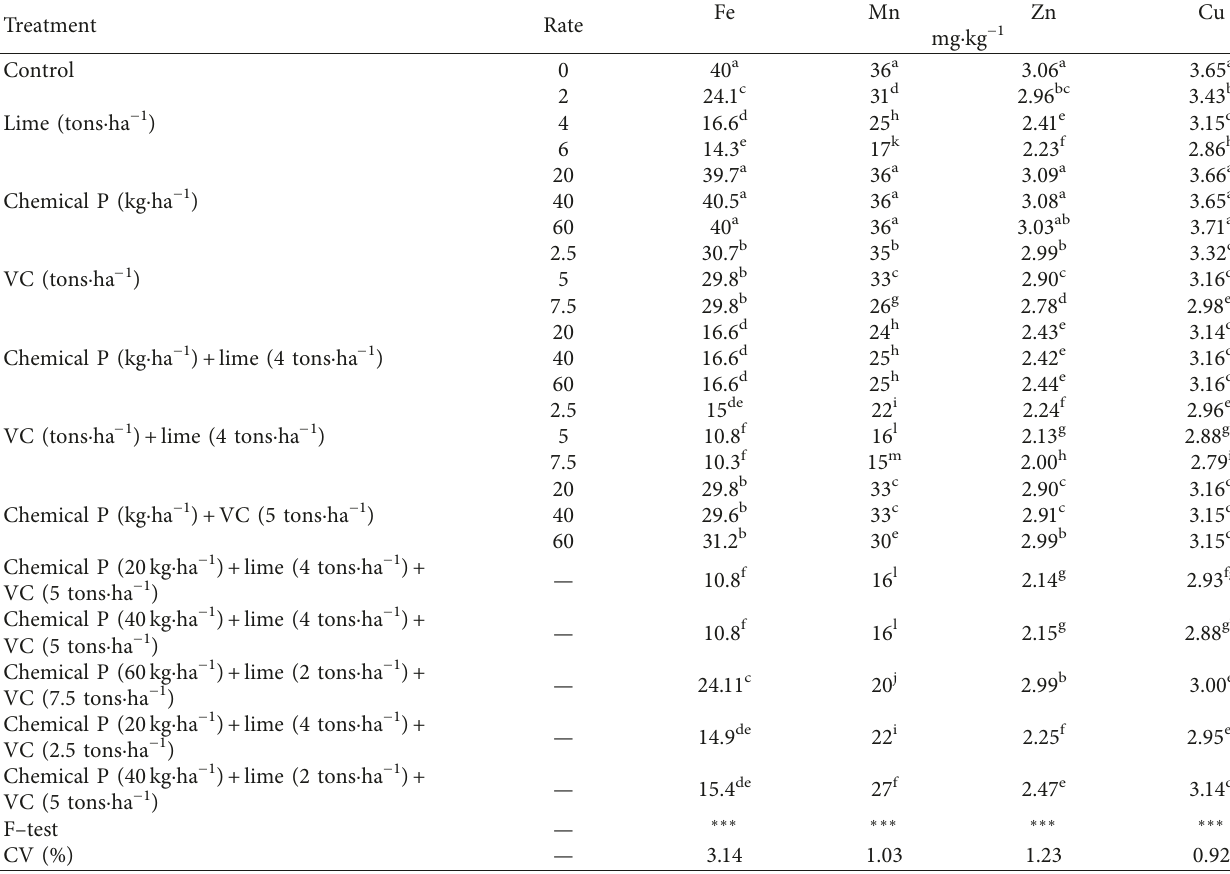
Table 7: The effects of treatments on extractable micronutrients (Fe, Mn, Zn, and Cu) of the soil of the study area.